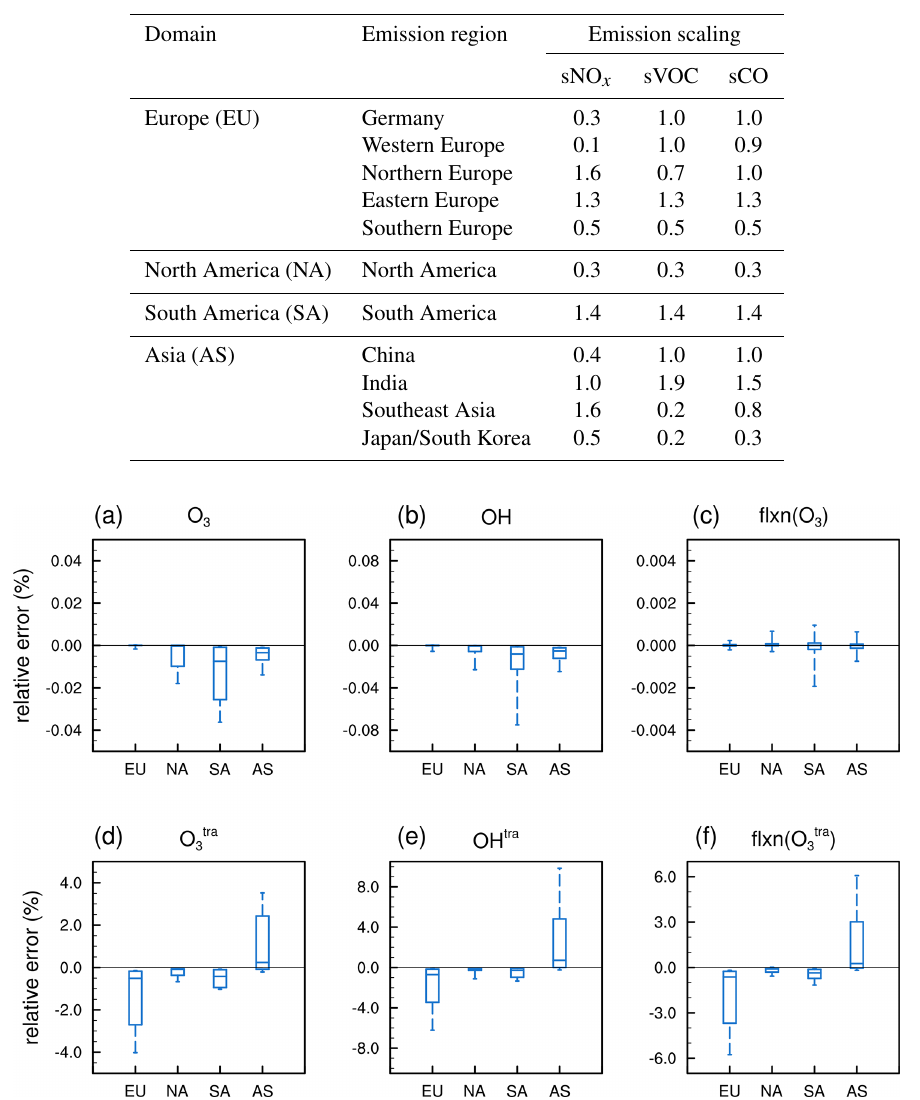
Table 3. Emission scaling factors for the evaluation of TransClim over the domains Europe, North America, South America and Asia. For each domain, the scaling factors of the remaining emission regions that are not listed in this table are kept constant at 1.